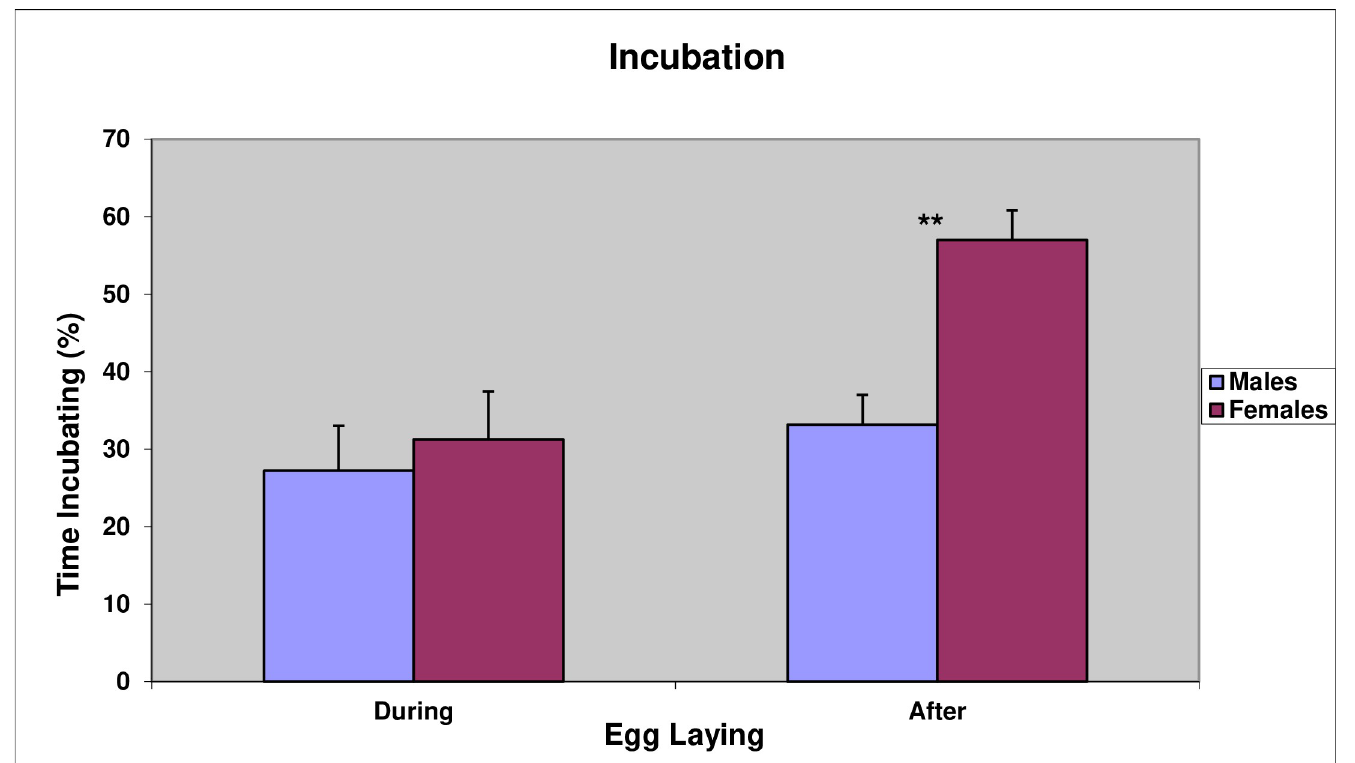
Fig 9. Mean percentage of time males and females of 15 pairs spent incubating prior to laying of the B-egg (i.e., during egg laying) and afterwards. �� indicates that the difference between males and females is highly significant (P < 0.01).